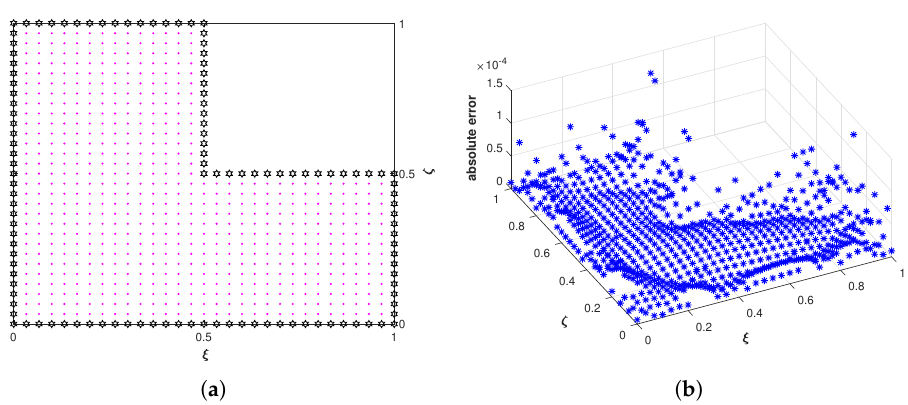
Figure 14. ( a ) L Shape domain n = 20, N = 736. ( b ) Absolute error of Problem 4 with α = 0.50, N = 736, n = 20, and M = 26. In L Shape domain also the method has acceptable accuracy.